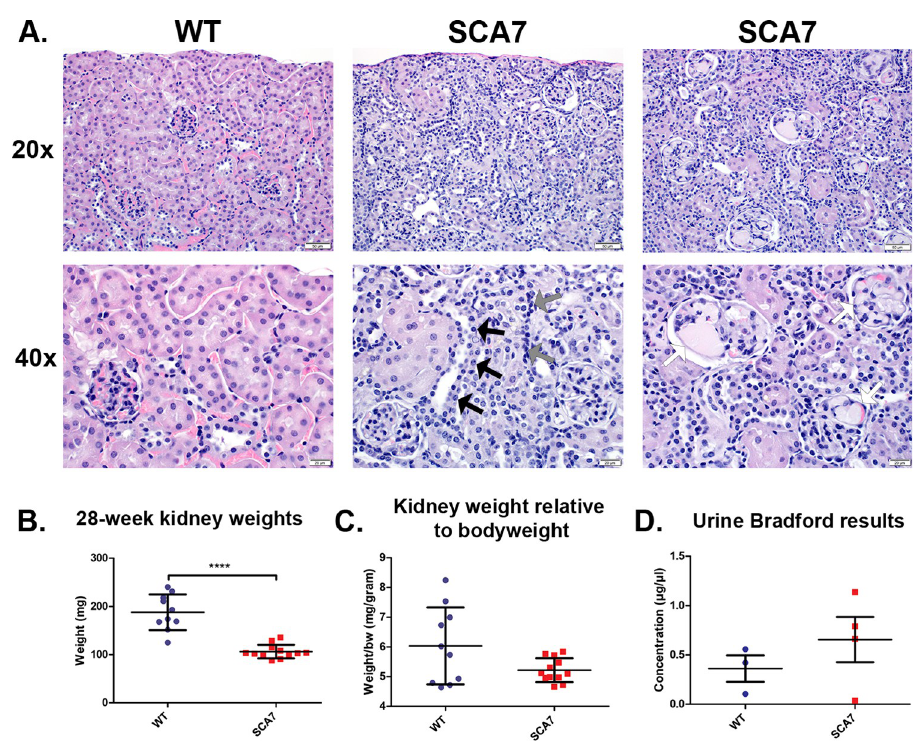
Fig 1. Kidney histologic and functional abnormality in SCA7 140Q/5Q mice. A) Kidney hematoxylin and eosin staining (H&E) of 40-week-old SCA7 140Q/5Q and WT littermates, B-C) absolute and relative kidney weights, and D) urine Bradford assay results of 28-week-old SCA7 140Q/5Q and WT littermates. SCA7 140Q/5Q mouse kidney demonstrates abnormal histological structure and decreased weight, likely related to kidney dysfunction. Renal hyperplasia (black and gray arrows) and glomeruli proteinosis (white arrows). Significance determined via two-tailed student’s t-test. ���� p � 0.0001.